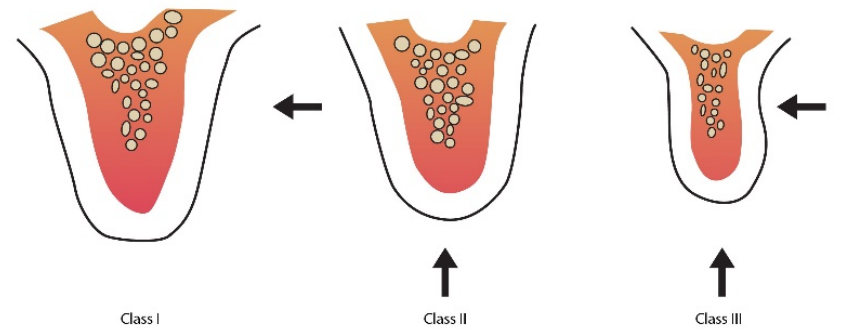
Figure 3. Ridge defect classification of edentulous patients according to Seibert (1983)